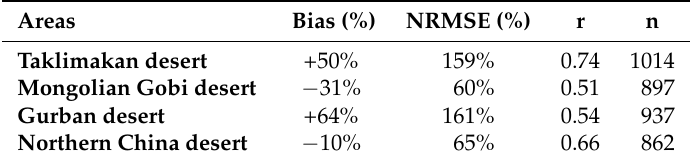
Table 2. Temporal correspondences between CHIMERE 550nm AOD and MODIS 550nm AOD, for 2011, 2013 and 2015 over main arid areas. NRMSE is the Normalized Root Mean Square Error. r is the correlation coefficient. n indicates number of daily mean value for sub